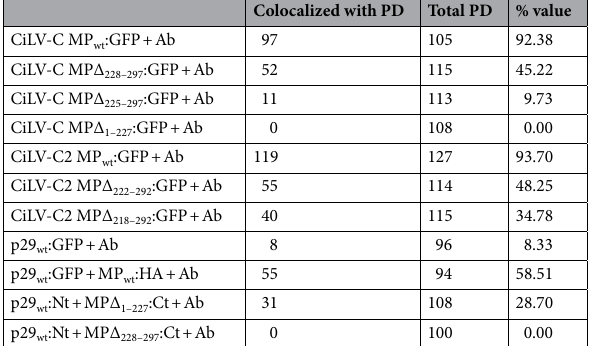
Table 1. Percentage of plasmodesmata which colocalize with cilevirus MPs, p29 and MP-p29 complexes. Ab aniline blue (callose staining), PD Plasmodesma, wt wild type, Nt N-part of the enhanced yellow fluorescent protein, Ct C-part of the enhanced yellow fluorescent